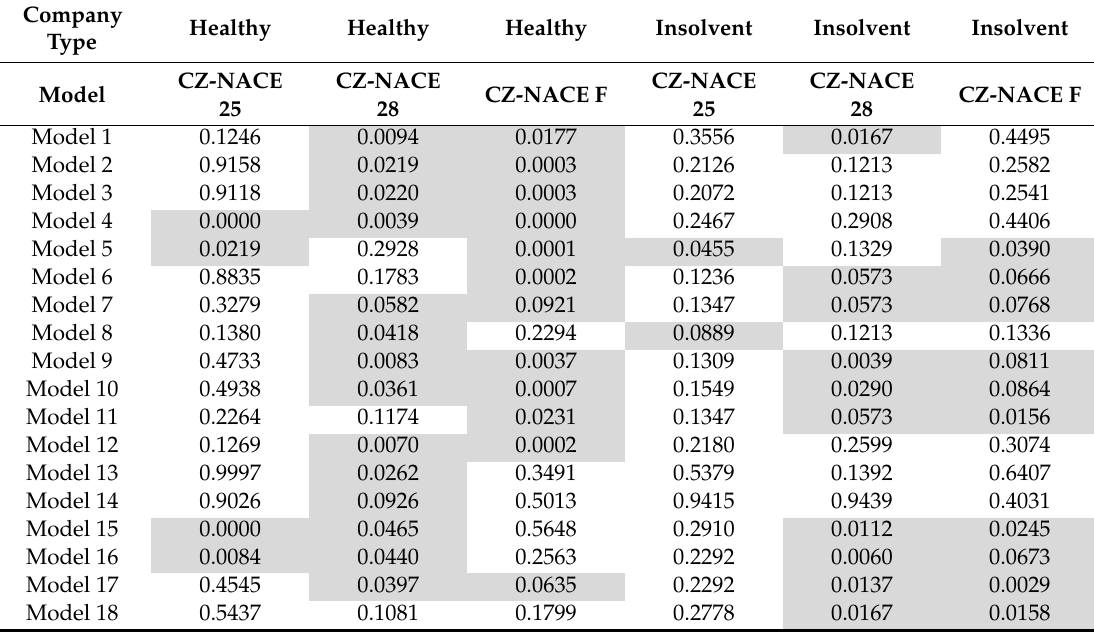
Table 3. p -values of the Wilcoxon